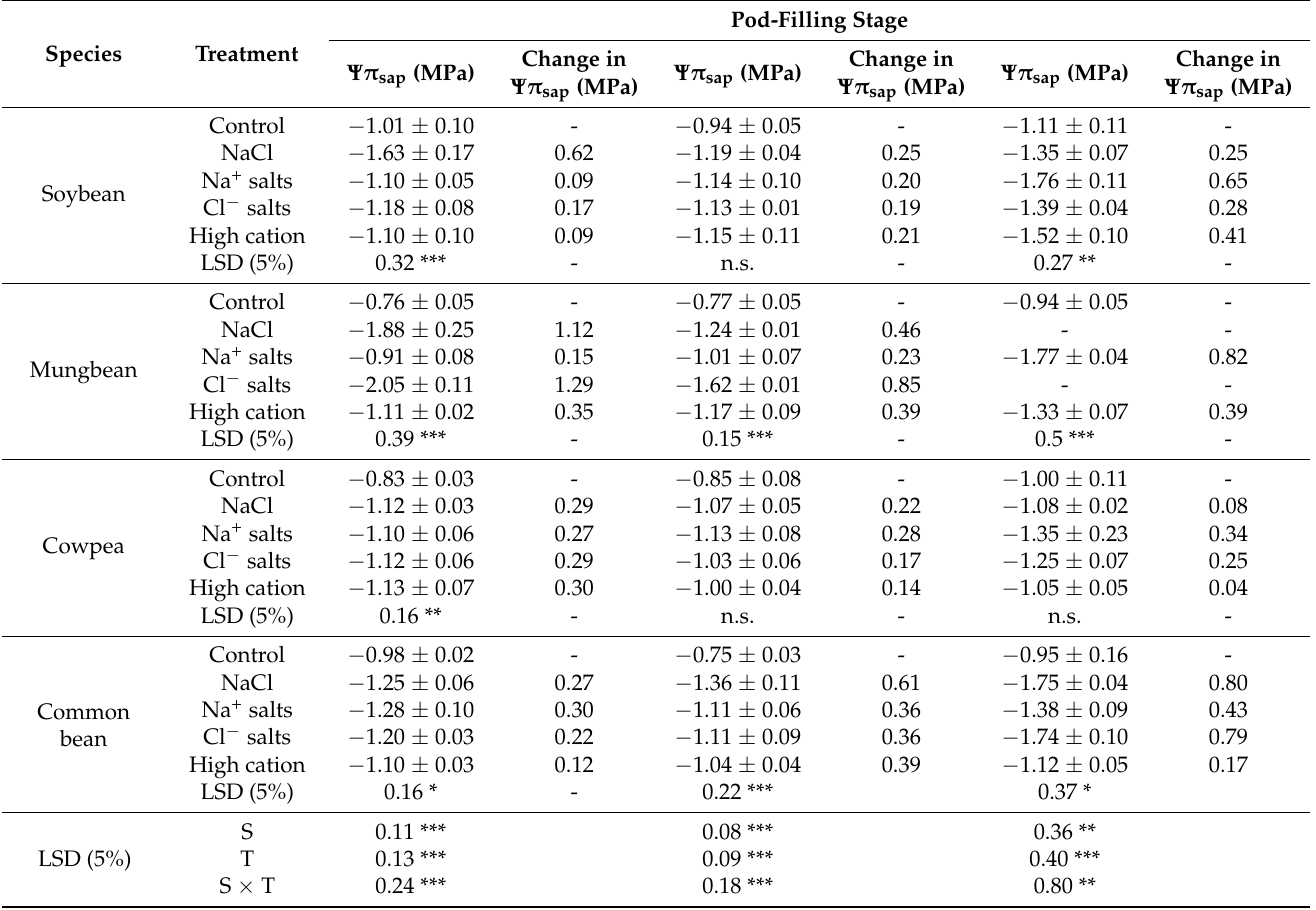
Table 3. Leaf sap osmotic potential ( Ψ π sap ) measured on the second-youngest fully expanded leaves (leaf lamina) of soybean, mungbean, cowpea, and common bean grown in control (non-saline), 100 mM NaCl, 100 mM Na + (without Cl − ), 100 mM Cl − (without Na + ), and high-cation negative control (K + , Mg 2+ , and Ca 2+ equivalent to those in the 100 mM Cl − treatment) treatment. The salts used in the various treatments are given in Table 1. Treatments were imposed on